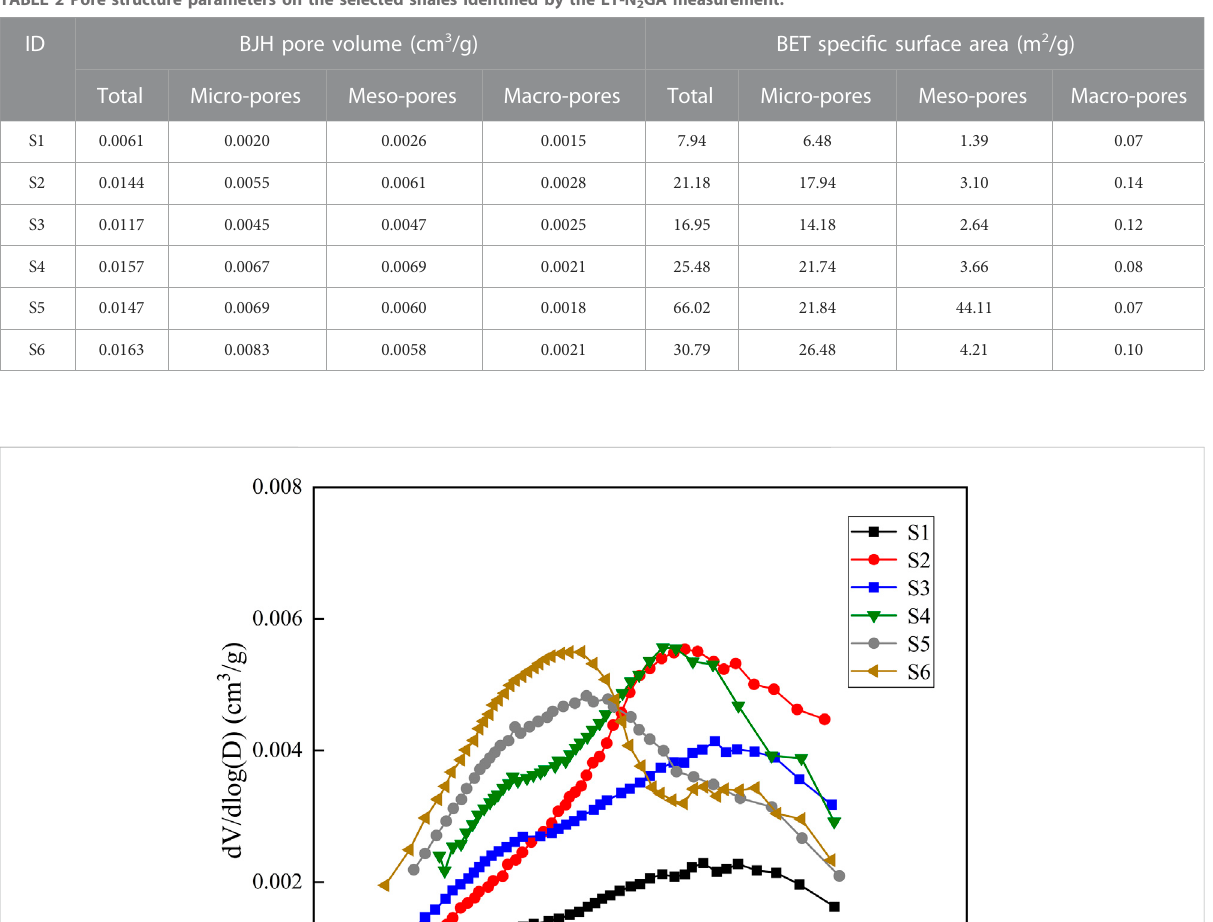
Frontiers in Earth